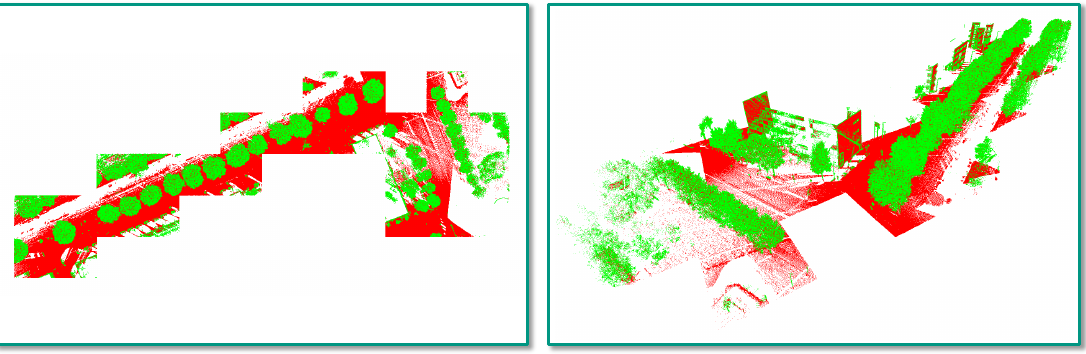
Figure 6. Visualization of a classification result derived with the feature set S FCBF ( left : nadir view; right : side view): those 3D points categorized as “tree points” are colored in green, whereas those 3D points categorized as “other points” are colored in red (the classification result corresponds to an overall accuracy of 90.71% and a kappa value of